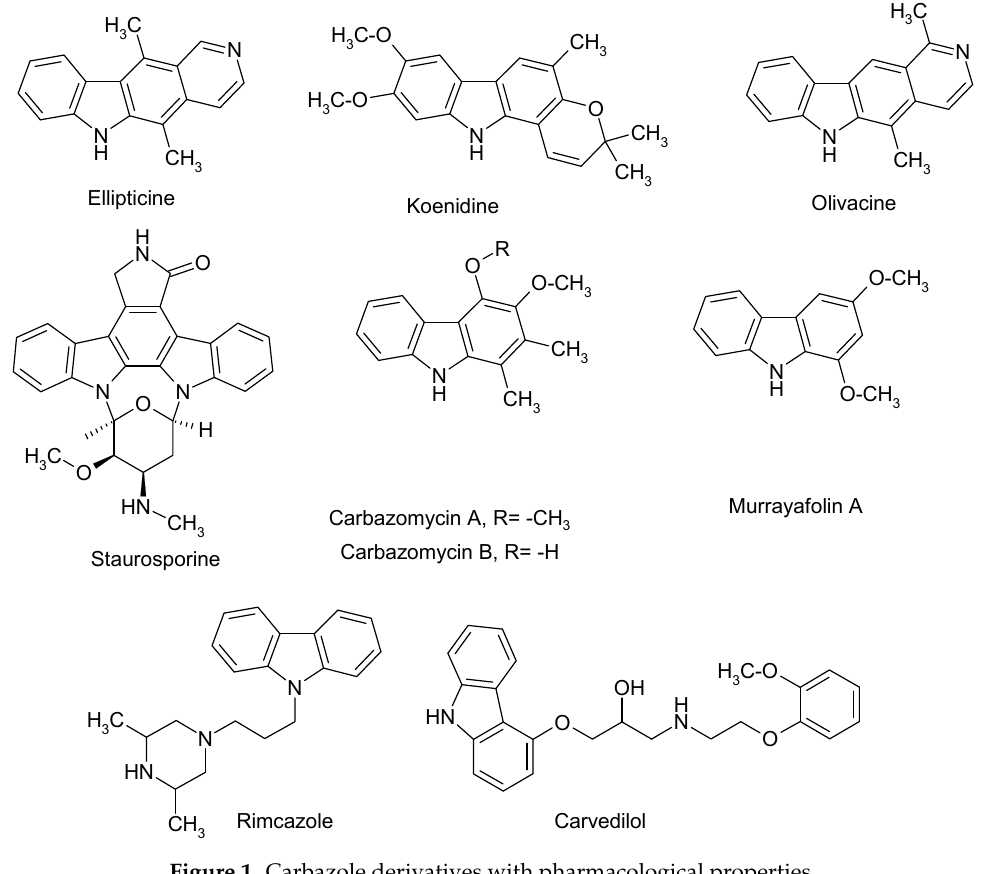
Figure 1. Carbazole derivatives with pharmacological properties. Molecules 2019 , 24 , x